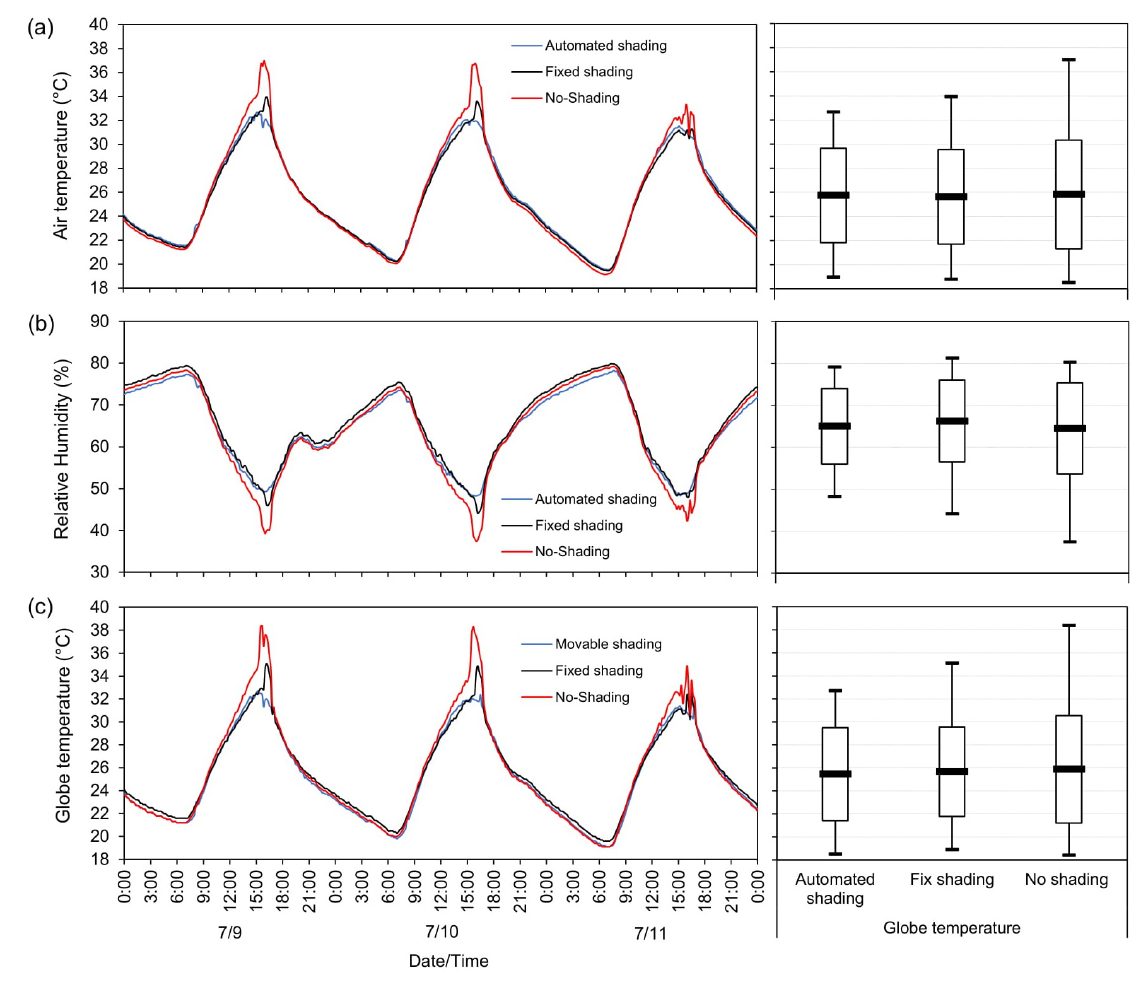
Fig. 7. Profiles of indoor thermal environments in the TH1, TH2 and TH3: (a) air temperature; (b) relative humidity; and (c) globe